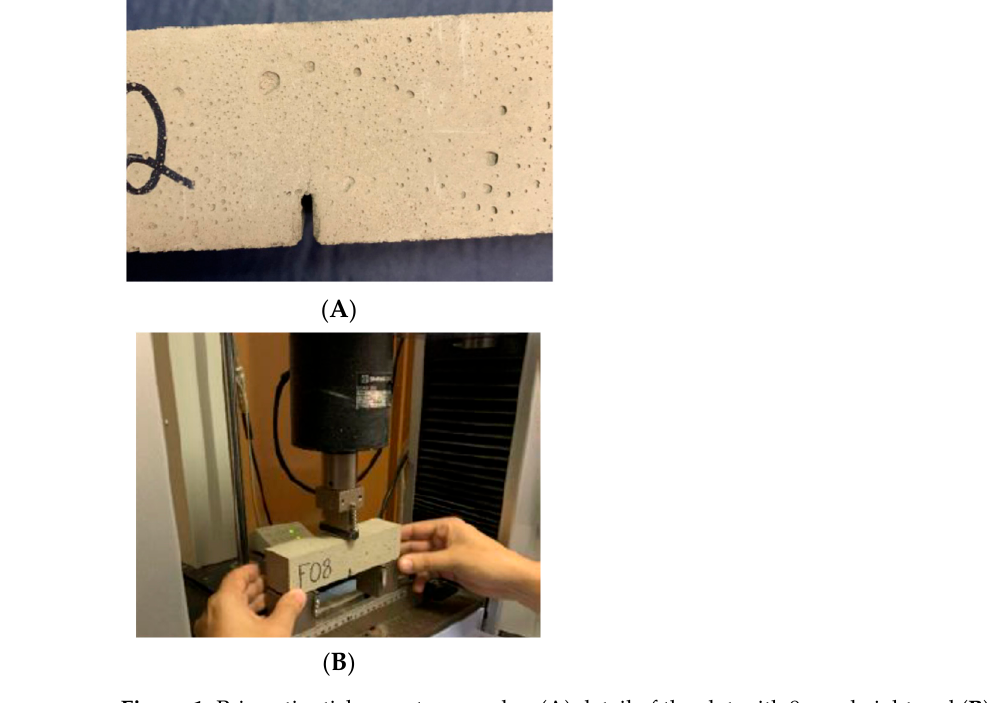
Figure 1. Prismatic sticky mortar samples: ( A ) detail of the slot with 9 mm height and ( B ) example of a sample fitted for the tests and the equipment used.